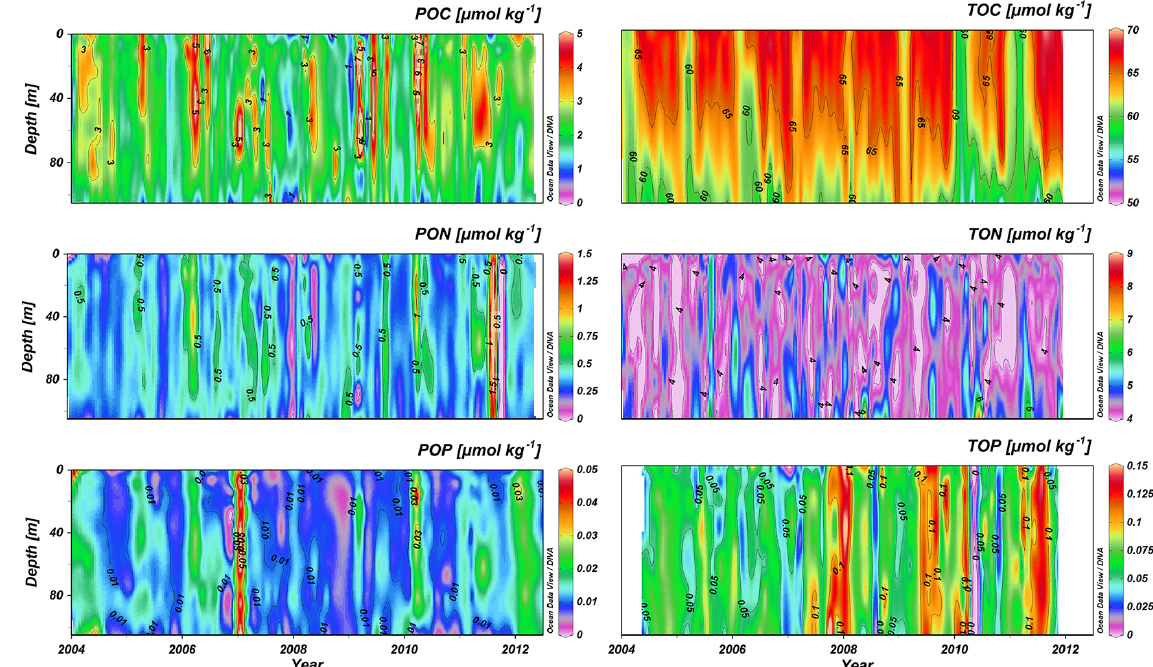
Figure 1. Monthly BATS data on C, N and P in total and particulate organic matter in the top 100m from January 2004 to April 2012.